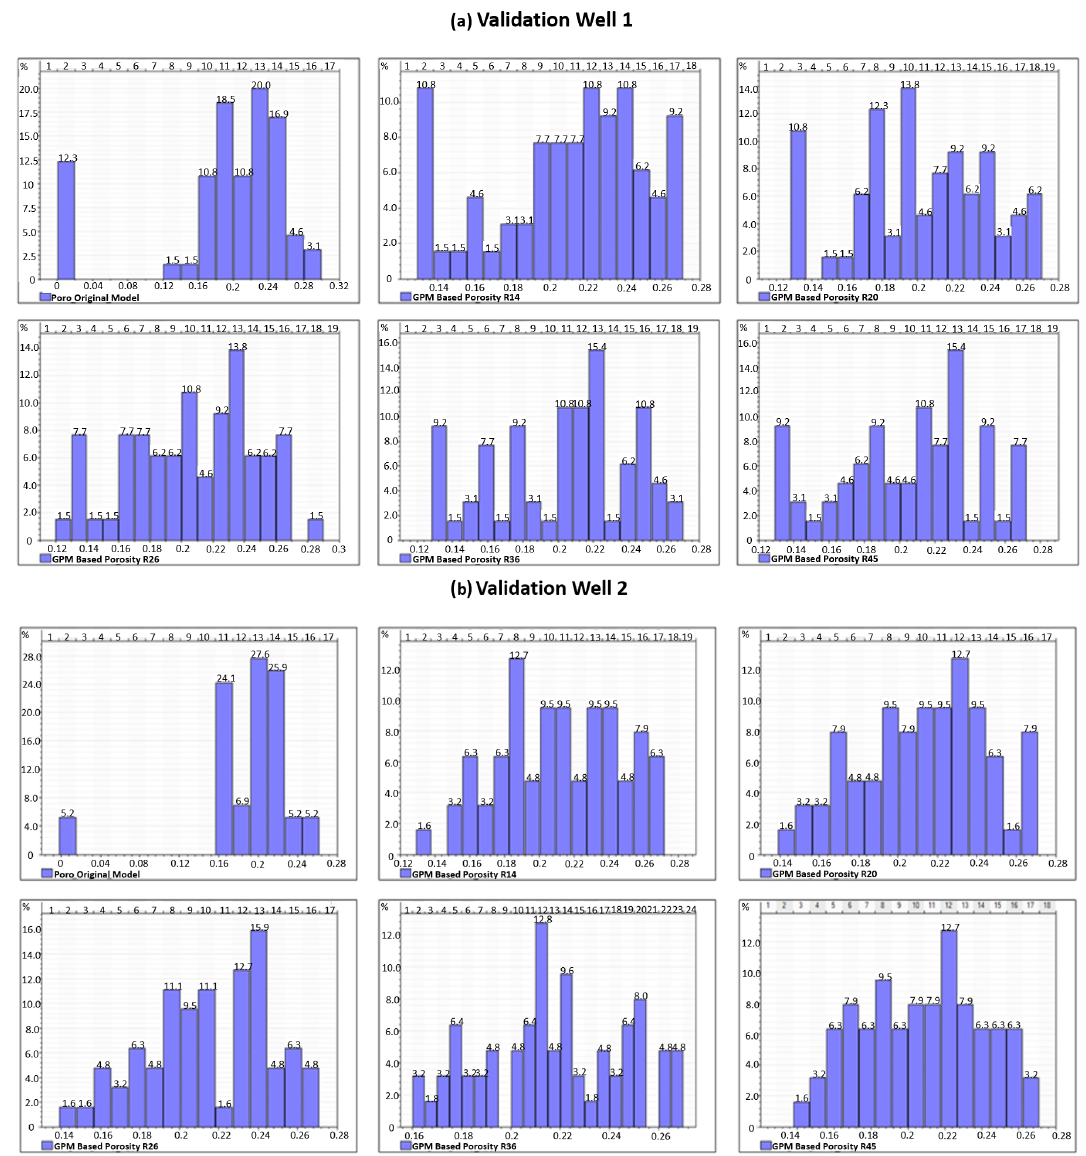
Figure 12. Histogram illustrating porosity distribution in validation wells 1 and 2 of five stratigraphic-based realizations and the original porosity model at identical vertical